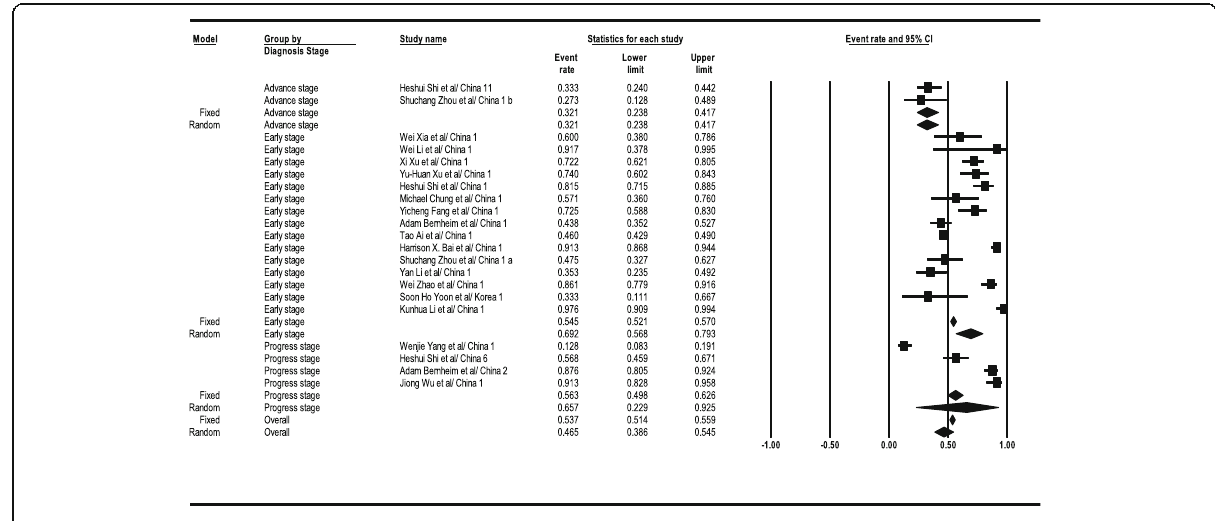
Fig. 2 Results of GGO in CT scan of patients